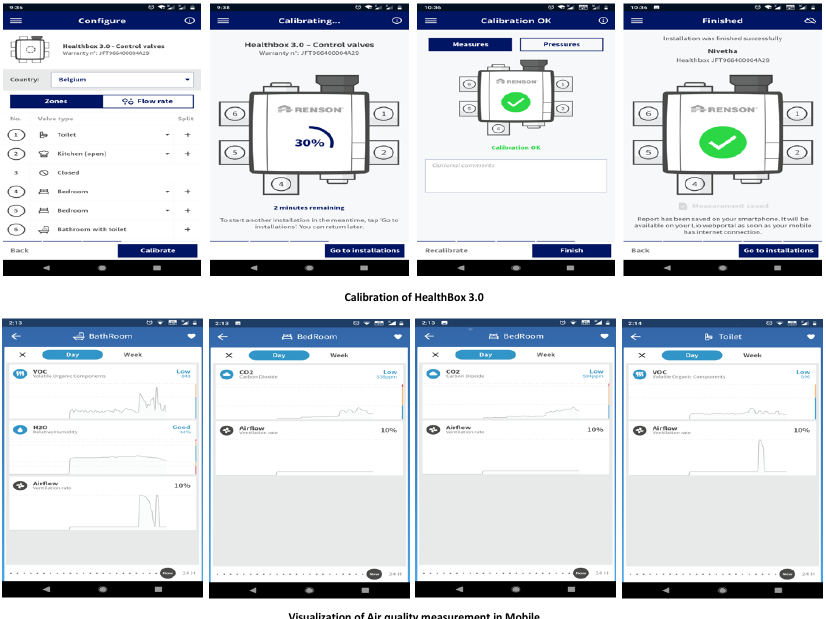
Figure 7. Calibration with MobileApp for Renson Healthbox